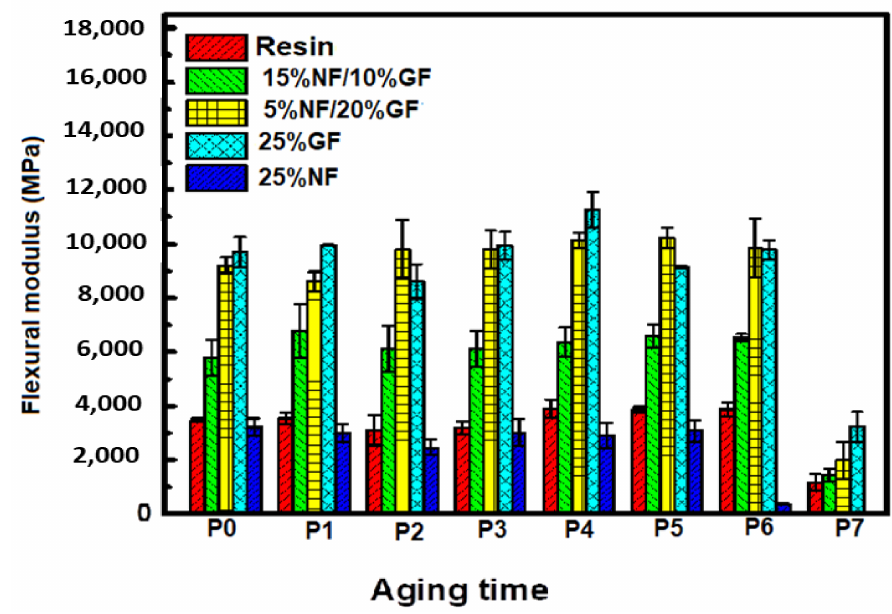
Figure 7. Flexural modulus evolution of hybrid composites during the aging